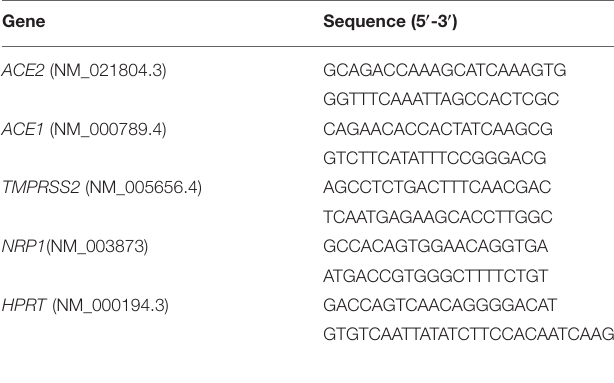
TABLE 1 | The primer sequences used for quantitative real-time PCR analysis.